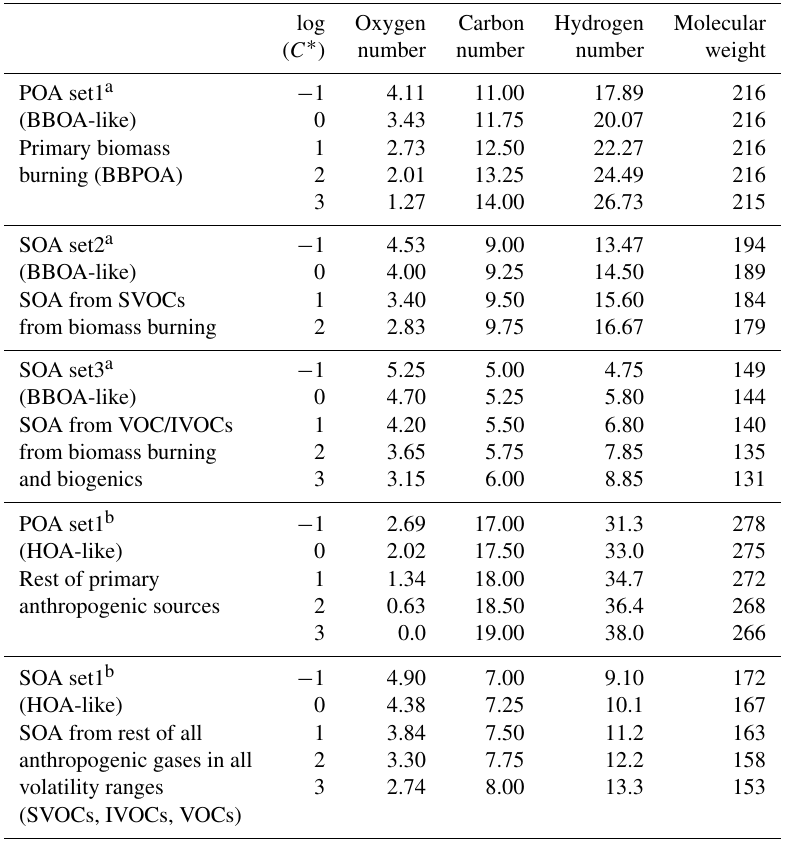
Table 1. Properties of the VBS space. Oxygen numbers for each volatility bin were calculated using the group-contribution of Donahue et al. (2011). Hydrogen numbers were calculated from the van Krevelen relation (Heald et al.,